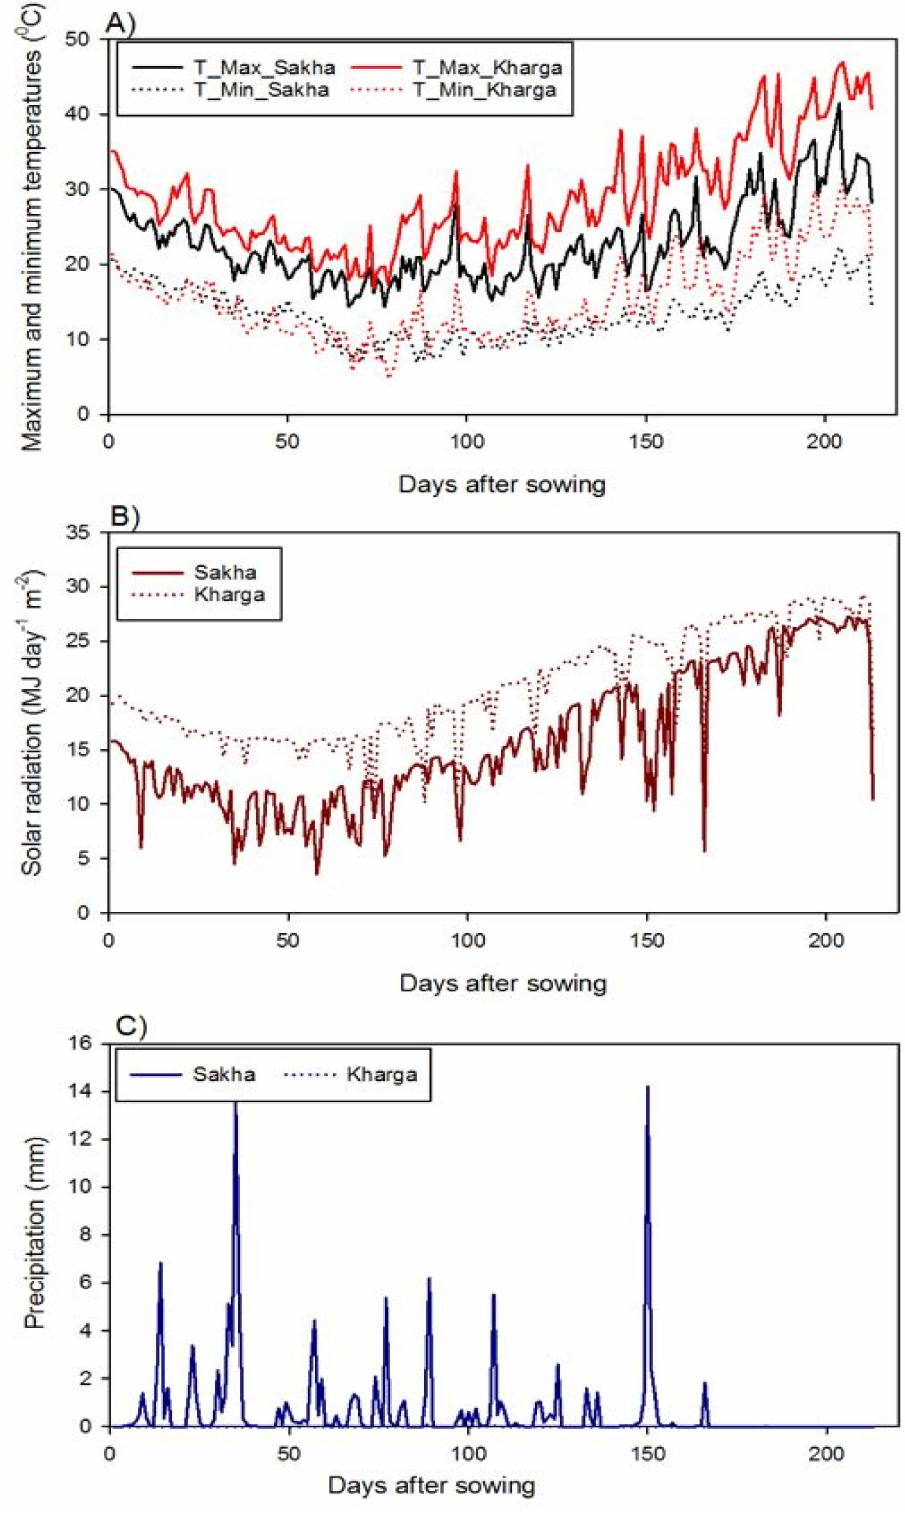
Figure 1. Daily maximum and minimum temperatures ( A ), solar radiation ( B ), and precipitation ( C ) at the two